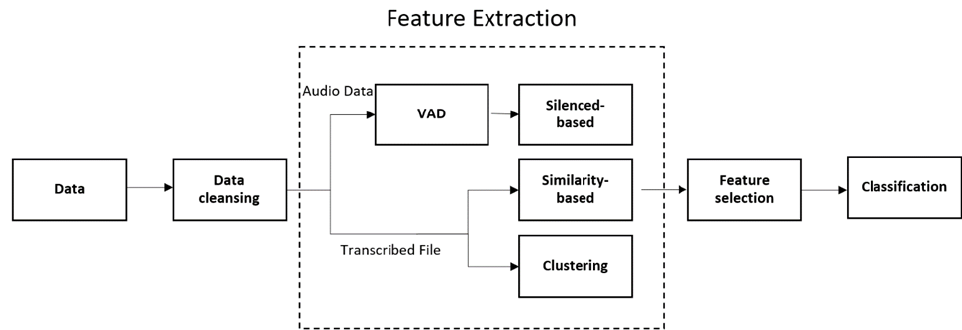
Figure 1. Our machine learning framework.